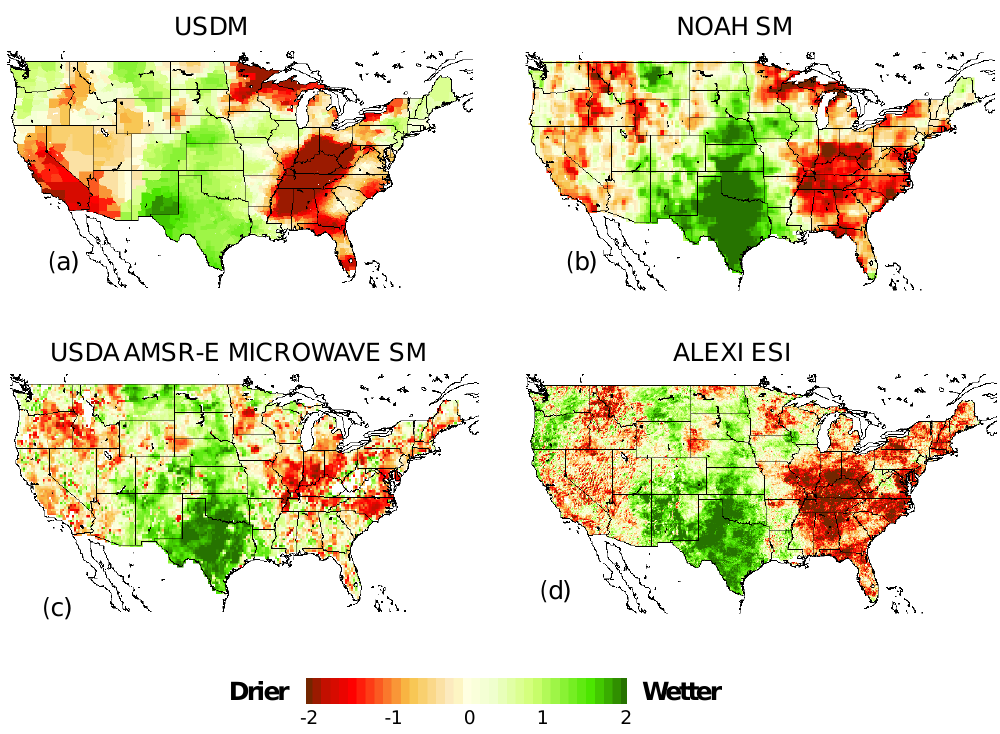
Fig. 6. Anomalies for the 2007 growing season (April–September) in (a) the USDM drought classes, (b) soil moisture predicted by the LIS- Noah land-surface model, (c) USDA AMSR-E (Advanced Microwave Scanning Radiometer – Earth Observing System) passive microwave soil moisture retrieval and (d) ALEXI